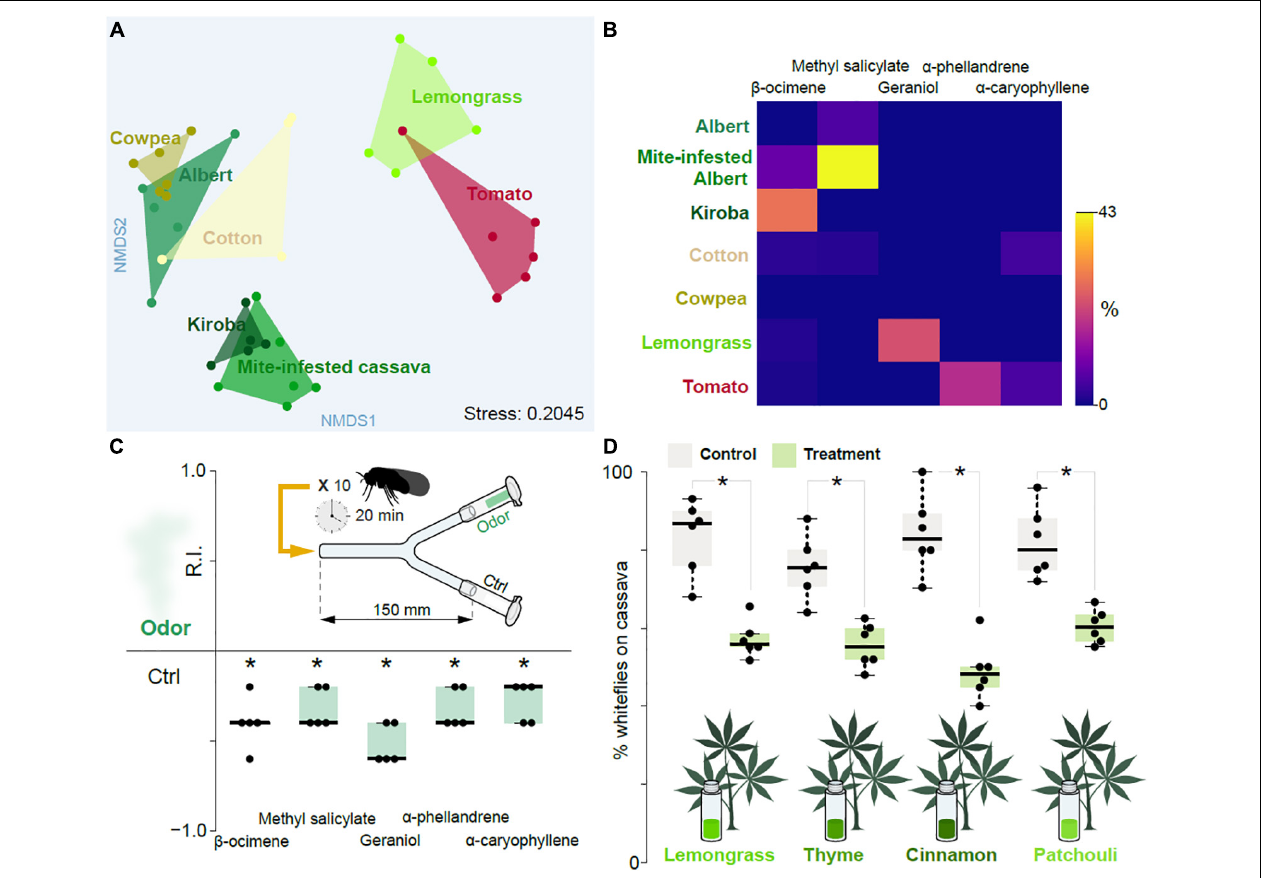
FIGURE 4 | Influence of plant-produced volatile chemicals. (A) NMDS plot showing the inter- and intra- relationship between the plant-produced volatile chemicals obtained from host plants of the cassava whitefly (cassava of variety Albert and Kiroba), alternative host plants (cowpeas, cotton and tomato), unsuitable host plant (mite-infested cassava plants) and non-host plant (lemongrass). (B) Heat map of the volatile chemicals identified from the head-space air of cassava of variety Albert and Kiroba, cowpeas, cotton, tomato, mite-infested cassava plants and Lemongrass showing the relative abundance of the potentially key volatile chemicals as determined from GC-MS analysis. (C) The response indices obtained from two-choice behavior assays with some of the plant-produced volatile chemicals thought to be the key chemicals responsible for the repulsion of the cassava whiteflies. The assays were done using individual chemicals and five replicates for each chemical. DMSO (at 1% dilution) was used as the control. One-sample Wilcoxon test statistics, with theoretical mean 0, was used to test the preference displayed on the Boxplots where the ∗ denotes significantly different from 0; p < 0.05. ANOSM and ANOVA were used to compare the results from the NMDS and Heatmap plots, respectively. (D) The response indices obtained from cassava leaves exposed to repulsive essential